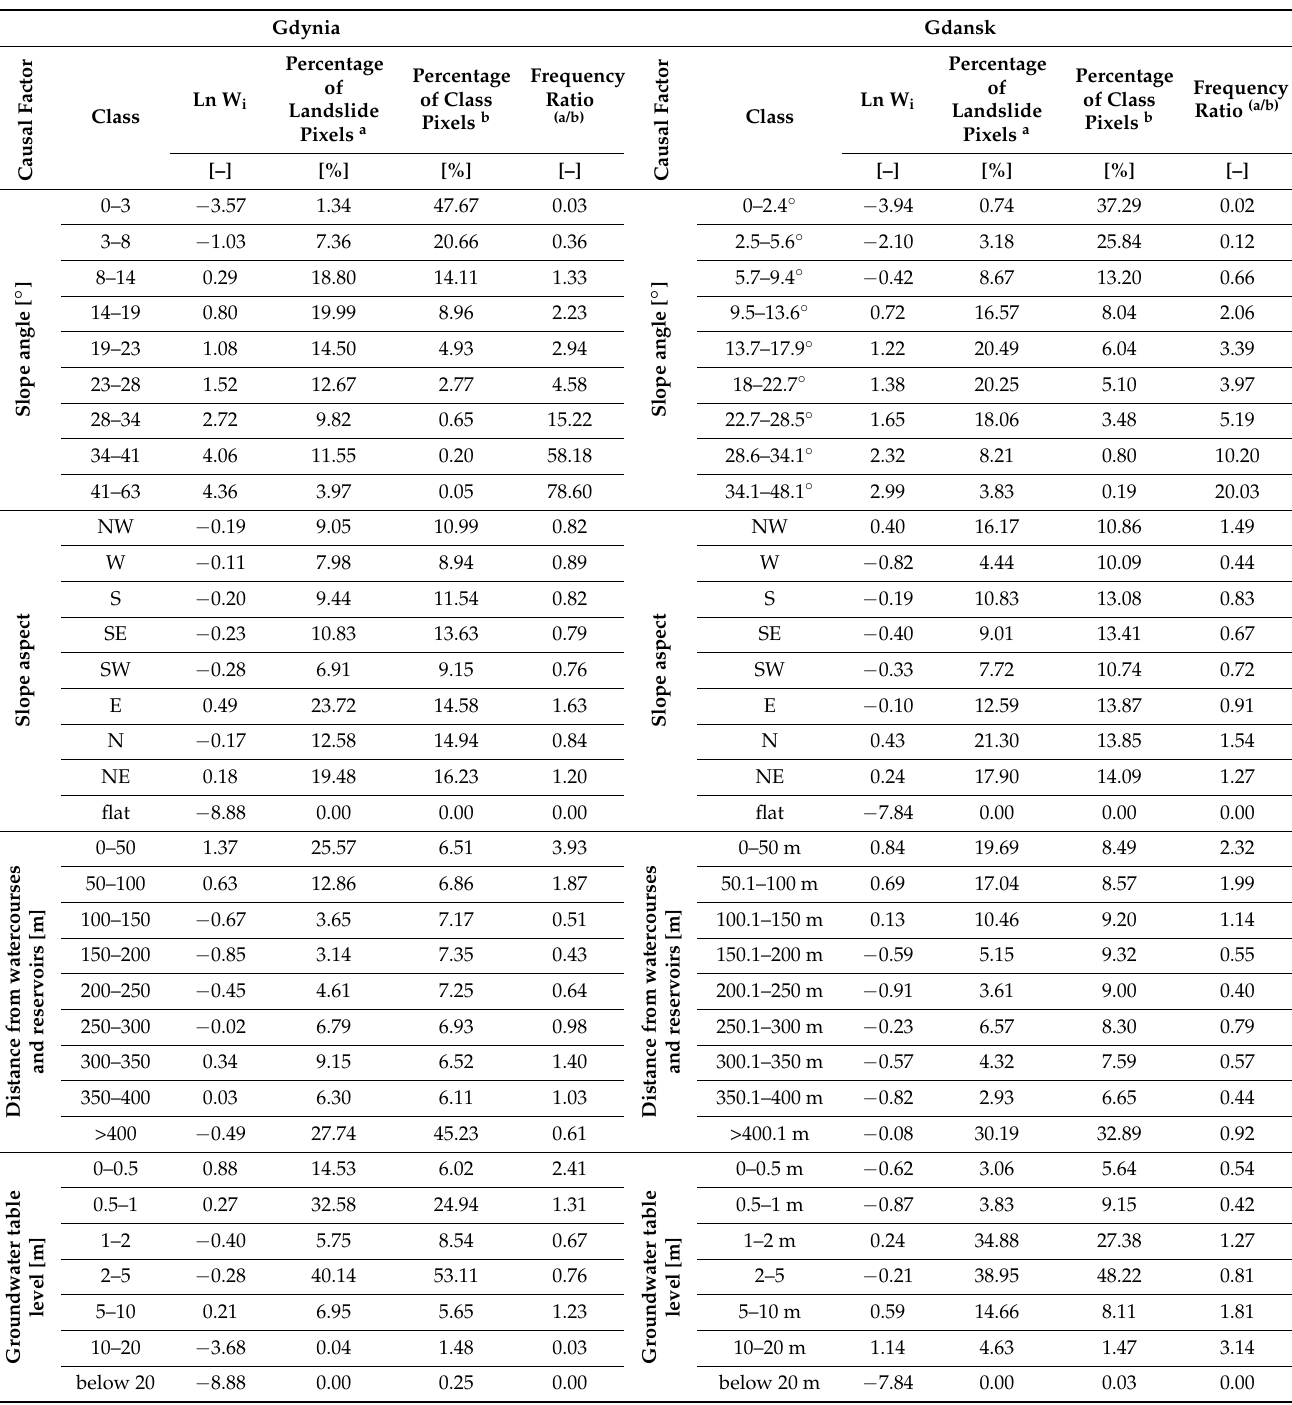
Table 3. Spatial relationship between the selected important conditioning factors and all landslides using the SLI for the entire landslide area in Gdynia and Gdansk. The LSI values (lnWi) were calcu- lated on the basis of the updated landslide inventory for Gdynia from 2018 [32] and for Gdansk on the basis of the complete landslide inventory from 2011 [3]; values with different signs (plus/minus) are highlighted in